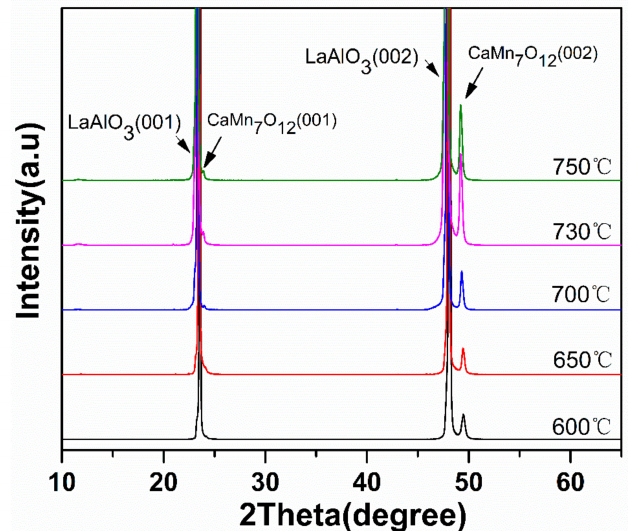
Figure 4. X-ray diffractometer (XRD) pattern of CaMn 7 O 12 ceramic films sintered at different